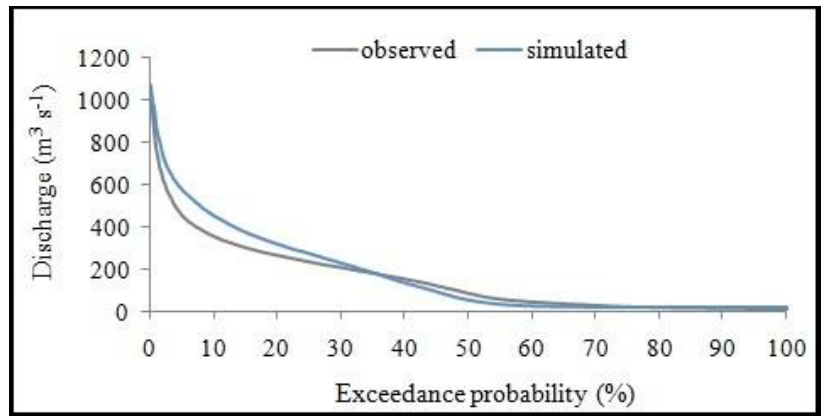
Figure 4. Long-term daily FDC of the Iya River at Tulun gauge over the period 1970–2019. To represent the performance of the water balance in the hydrological model, a graph of the interannual dynamics of the observed and simulated runoff coefficients of the Iya River at Tulun gauge over the period 1970–2019 is plotted (Figure 5).